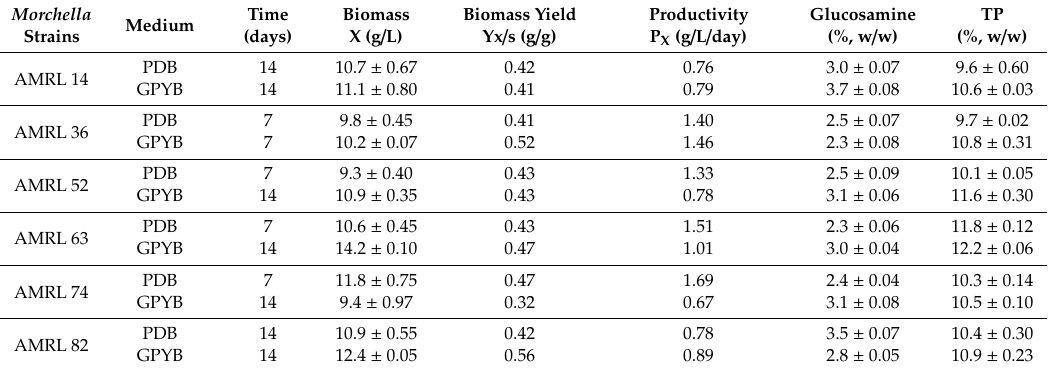
Table 2. Maximum biomass production and glucosamine and total polysaccharide (TP) content of Morchella strains, during submerged fermentations in potato dextrose broth (PDB) and glucose-based broth (GPYB).